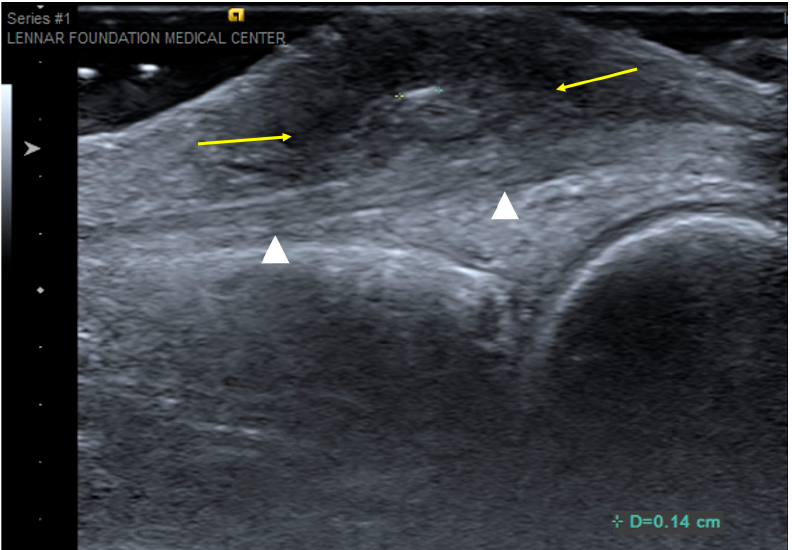
Figure 12. Foreign-body granuloma. Longitudinal ultrasound over dorsal aspect of the middle finger at the level of the metacarpophalangeal joint shows a 1.4 mm echogenic foreign body (digital calipers) and surrounding heterogeneously hypoechoic inflammatory soft-tissue reaction (arrows). The underlying extensor tendon (arrowheads) was confirmed to be normal at